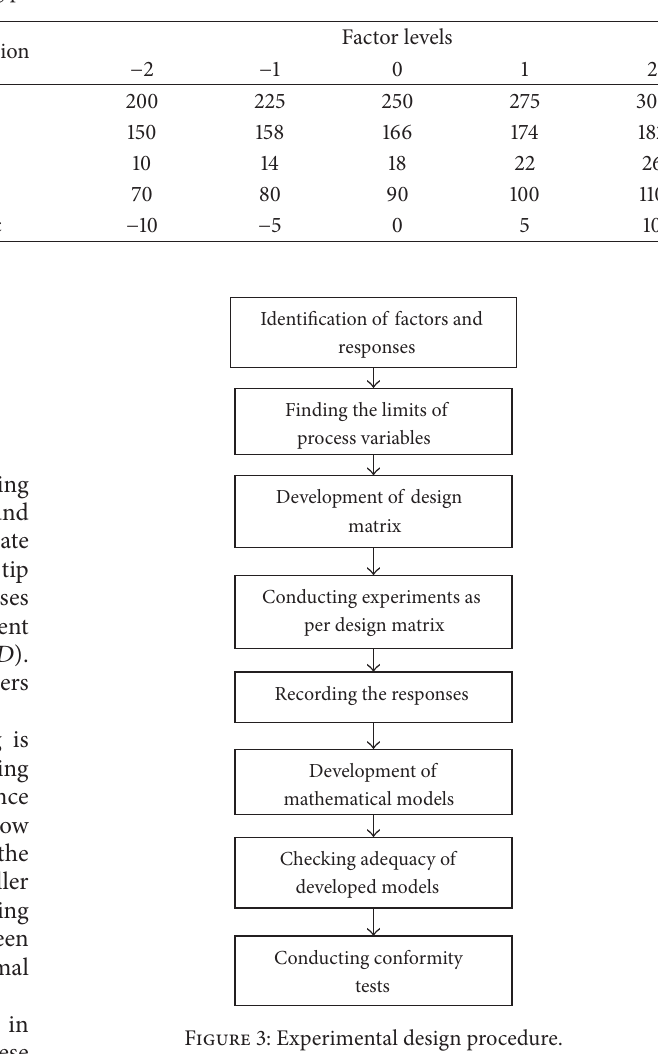
Table 2: Welding parameters and their levels.